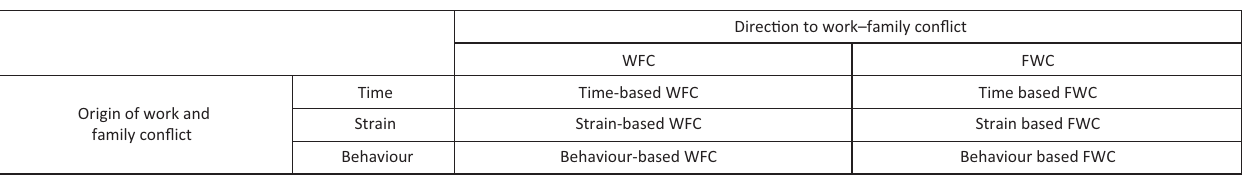
FIGURE 1: Multidimensional measure of work–family